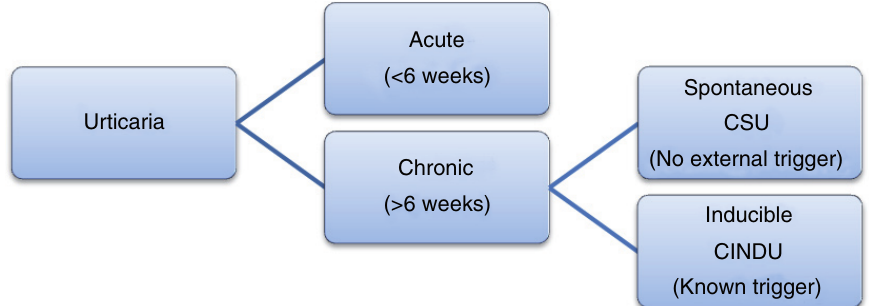
Figure 1. Classification of Urticaria. The revised classification of urticaria divides chronic urticaria into chronic spontaneous urticaria (CSU), with no external trigger, and chronic inducible urticaria (CINDU), with an identifiable trigger. Acute urticaria remains as that which lasts less than 6 weeks.